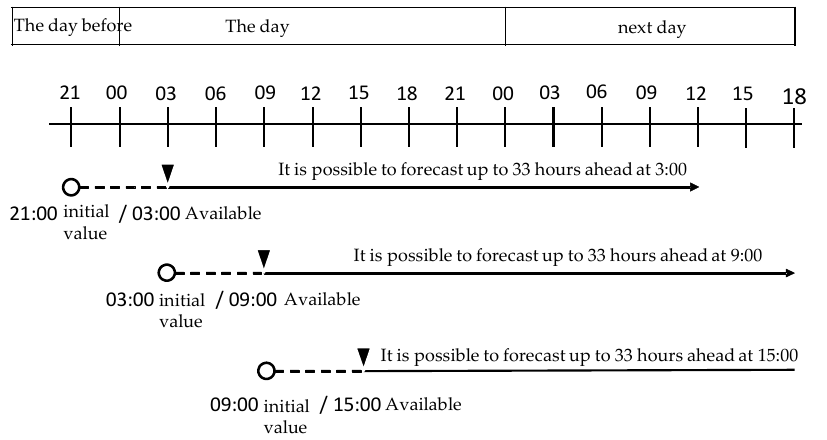
Figure 2. Forecast schedule using GPV-MSM. Each of the three horizontal lines represents distinct product runs initiated from different individual GPV-MSM forecast initializations.